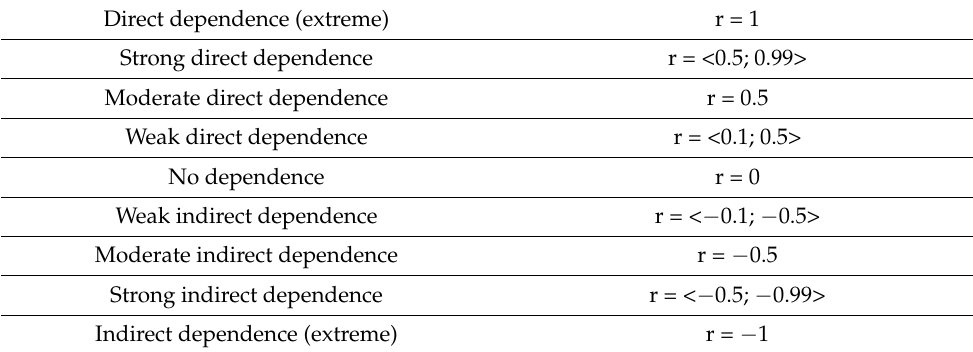
Table 1. Strength of dependence in